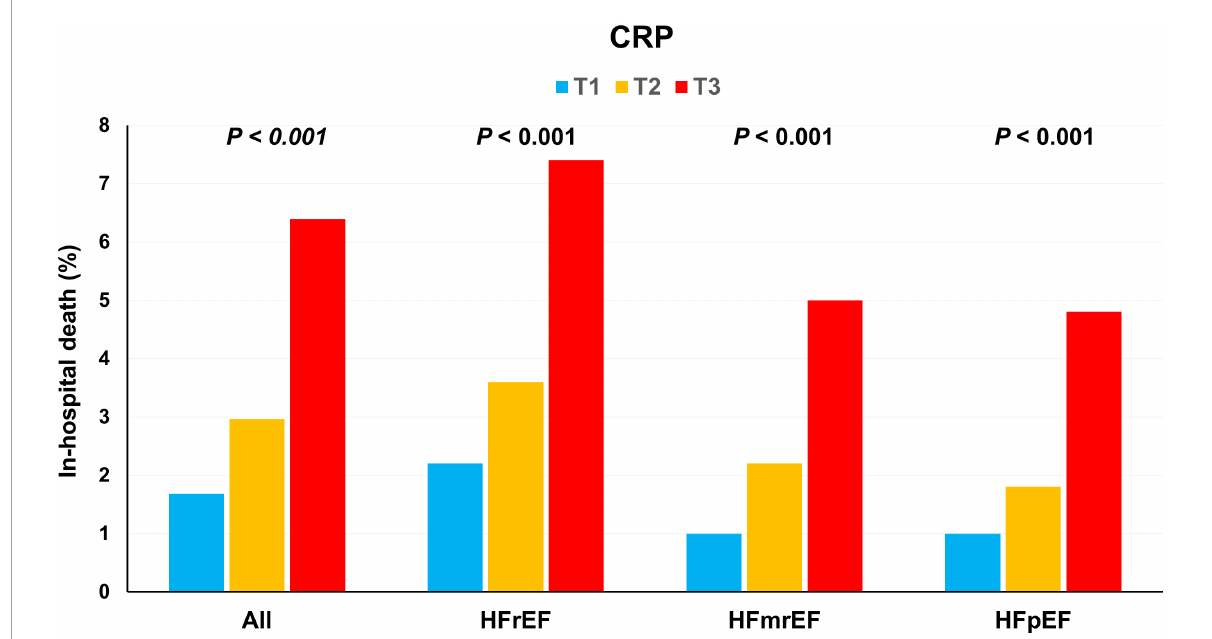
FIGURE1 In-hospital mortality according to the C-reactive protein (CRP) tertiles. In-hospital mortality increased with an increase in the CRP tertiles in HFrEF, HFmrEF, HFpEF, and whole population. CRP, C-reactive protein; HFmrEF, heart failure with mild reduced ejection fraction; HFpEF, heart failure with preserved ejection fraction; HFrEF, heart failure with reduced ejection